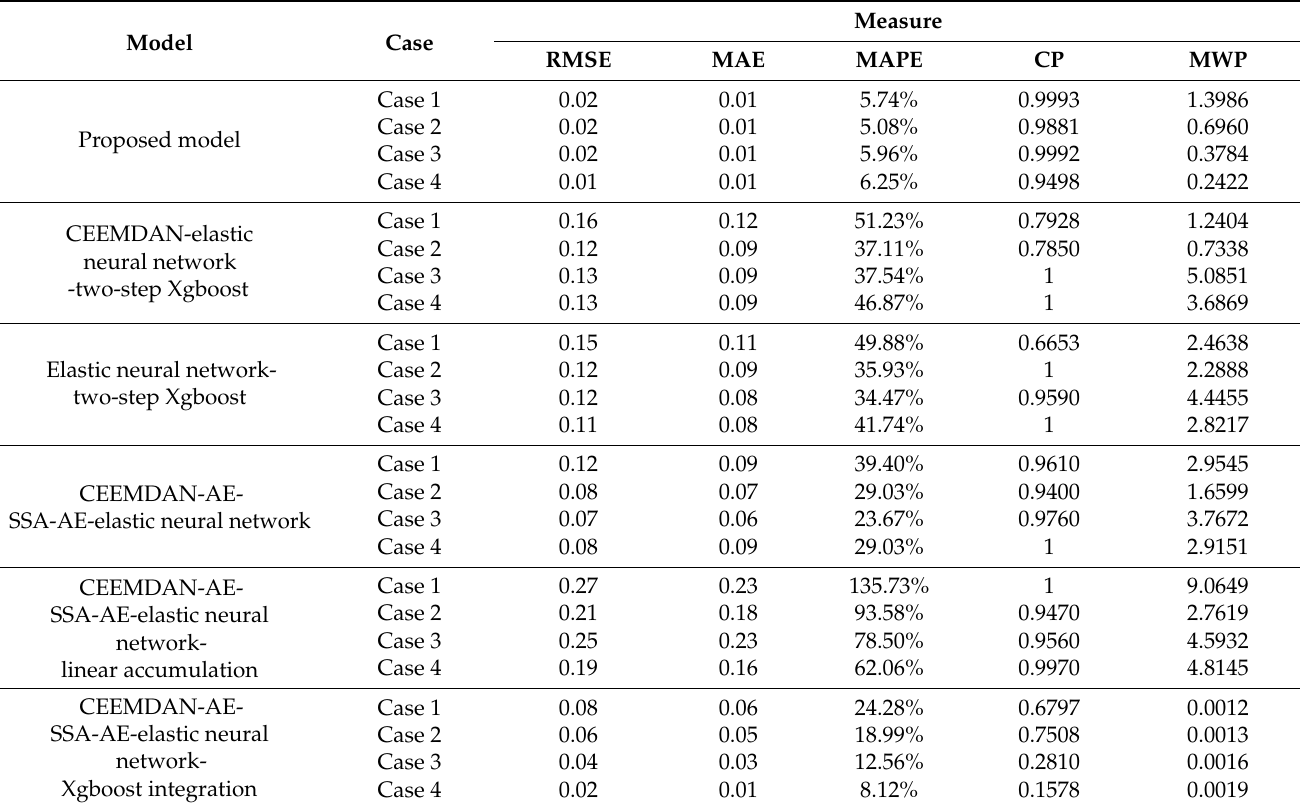
Table 8. Measures of